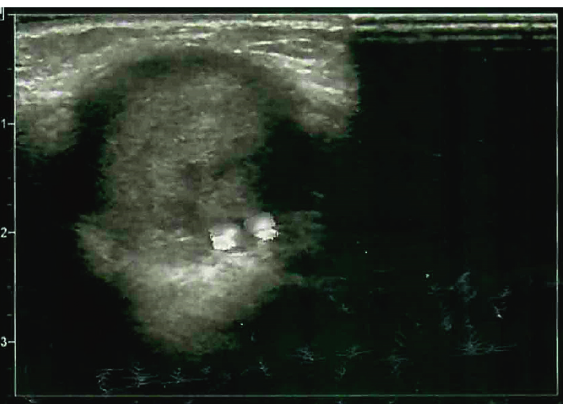
Figure 3: Radial artery aneurysm filled with thrombotic masses (an ultrasound image).